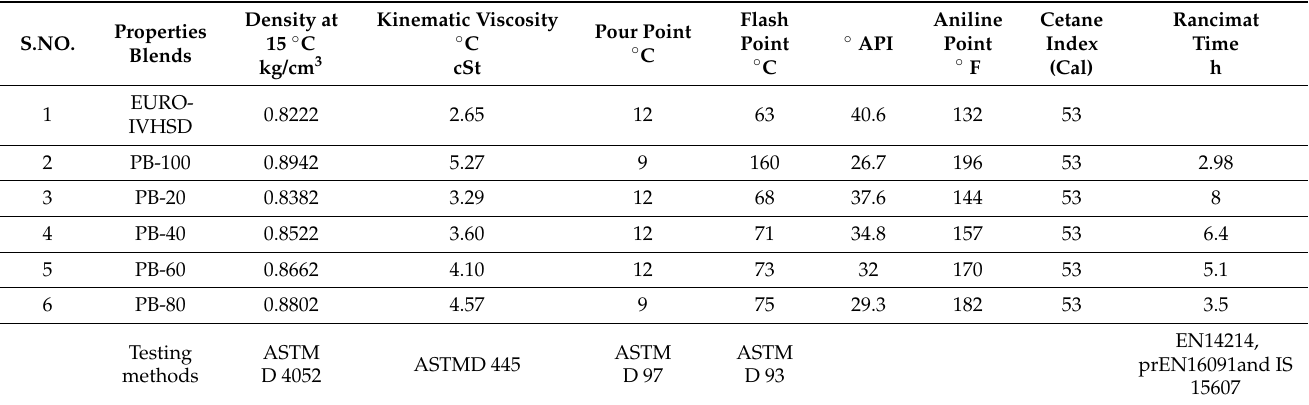
Table 8. Physical and chemical properties of EURO-IV HSD and Pongamia pinnata methyl ester blends